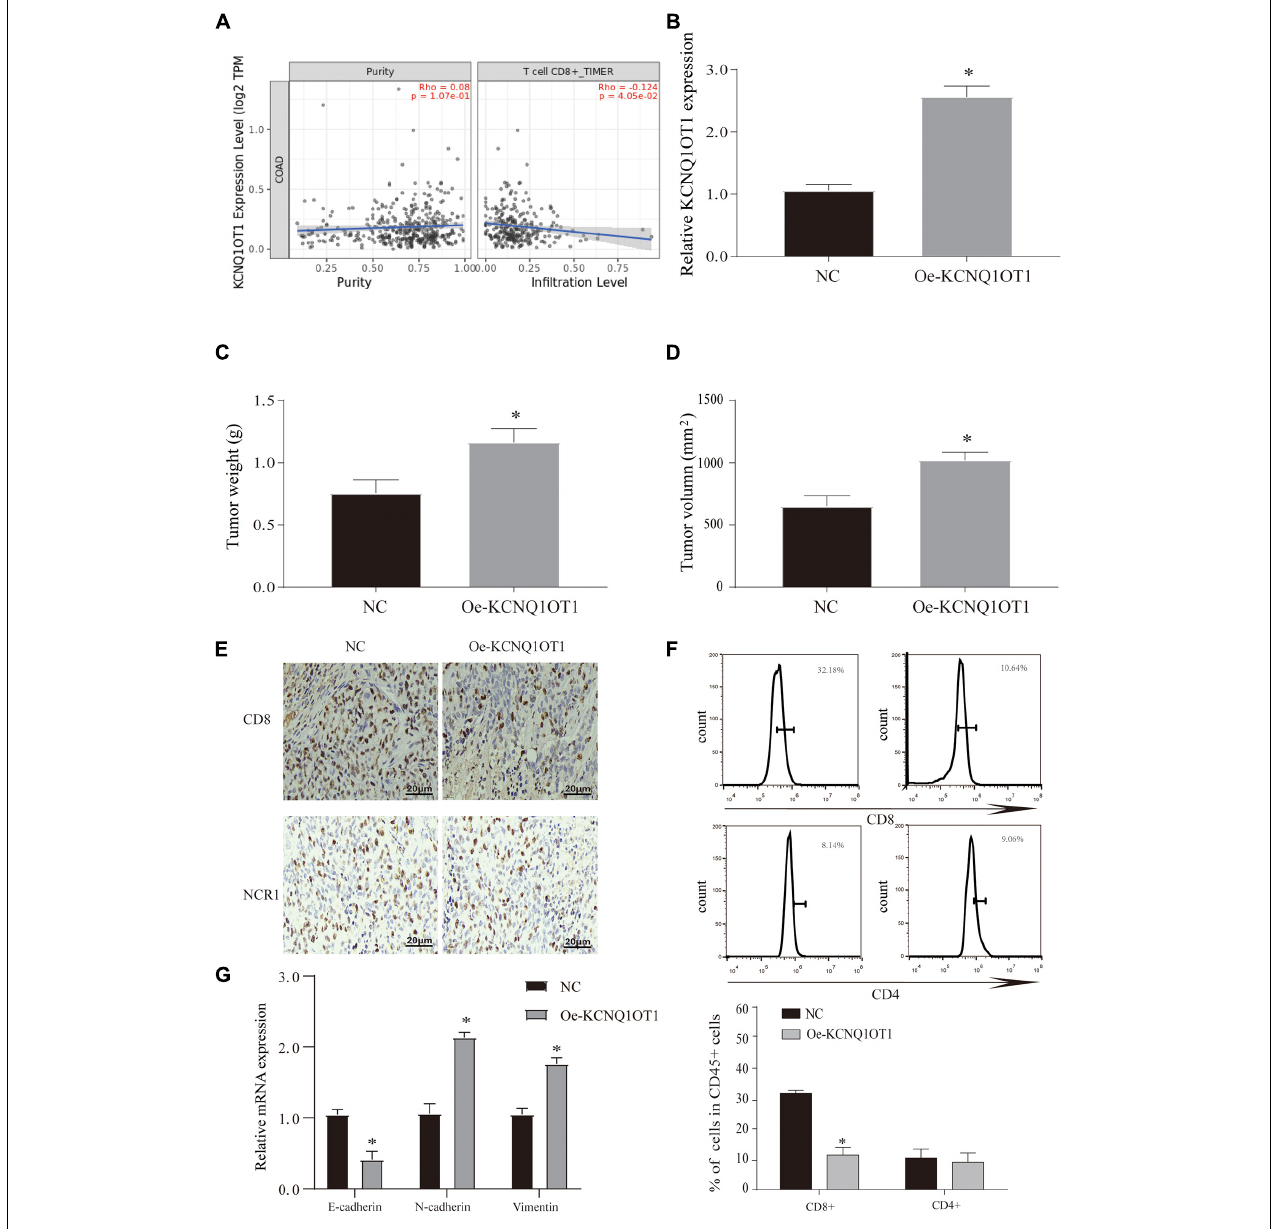
FIGURE 5 | Long non-coding RNA (lncRNA) KCNQ1OT1 can promote immune escape of colorectal cancer (CRC) cells. (A) The TIMER 2.0 database is used to detect the correlation between KCNQ1OT1 and CD8+ T cells. (B) The expression of KCNQ1OT1 in tumor tissues from different treatment groups in BALB/c mice. (C,D) Tumor size and weight after different treatments in BALB/c mice. (E) Immunohistochemistry was used to detect the expression of CD8 and NCR1 in tumor tissues. NCR1 was used as a marker of natural killer cells. (F) Flow cytometry is used to detect the content of CD8+ and CD4+ T cells in tumor tissues. (G) The expression of epithelial–mesenchymal transition (EMT)-related proteins. ∗ p < 0.05 compared with the NC group, N =